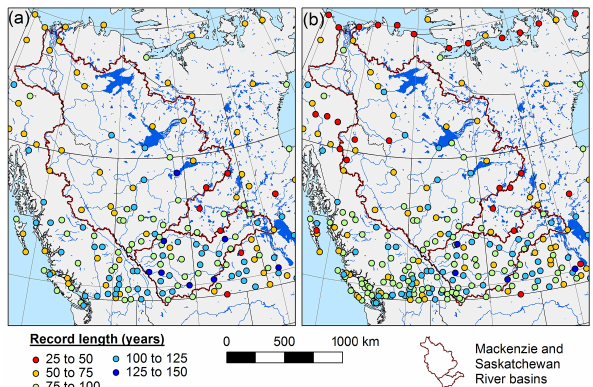
Figure 2. Map of station density and record length for (a) temper- ature and (b) precipitation measurements used in the AHCCD of Environment Canada